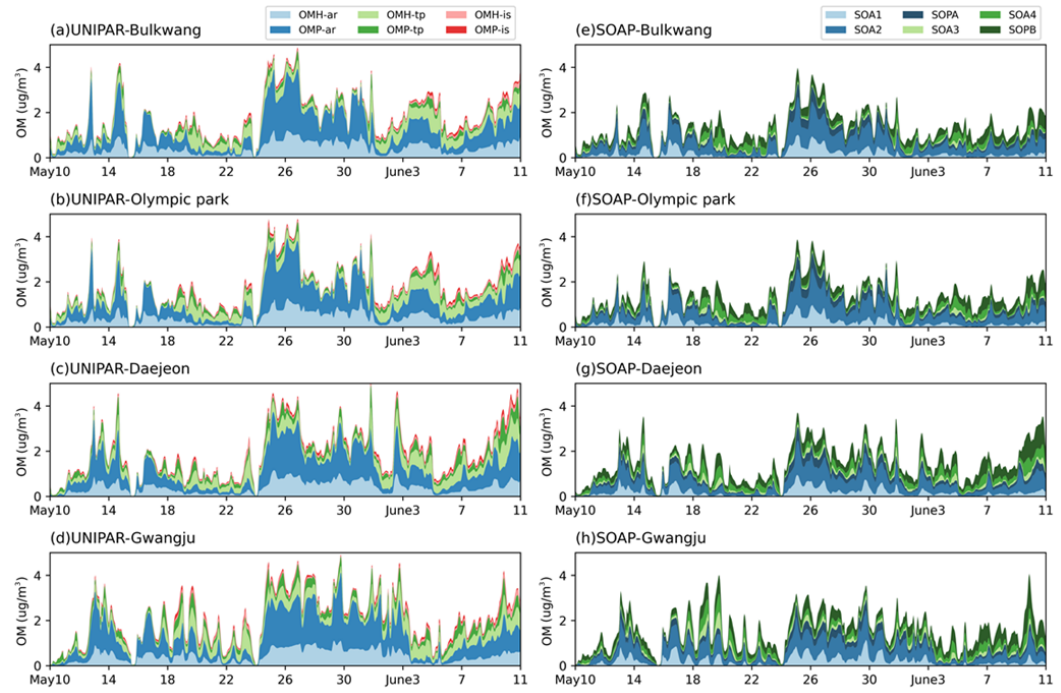
Figure 7. Time profiles of stacked OM concentrations predicted by CAMx–UNIPAR at the (a) Bulkwang, (b) Olympic Park, (c) Daejeon, and (d) Gwangju supersites and by CAMx–SOAP at the (e) Bulkwang, (f) Olympic Park, (g) Daejeon, and (h) Gwangju supersites. “OMH” and “OMP” represent the OM formed through heterogeneous reactions and the gas–particle partitioning process, respectively. “ar”, “te”, and “is” represent the SOA formed from aromatic hydrocarbons, terpenes, and isoprene,